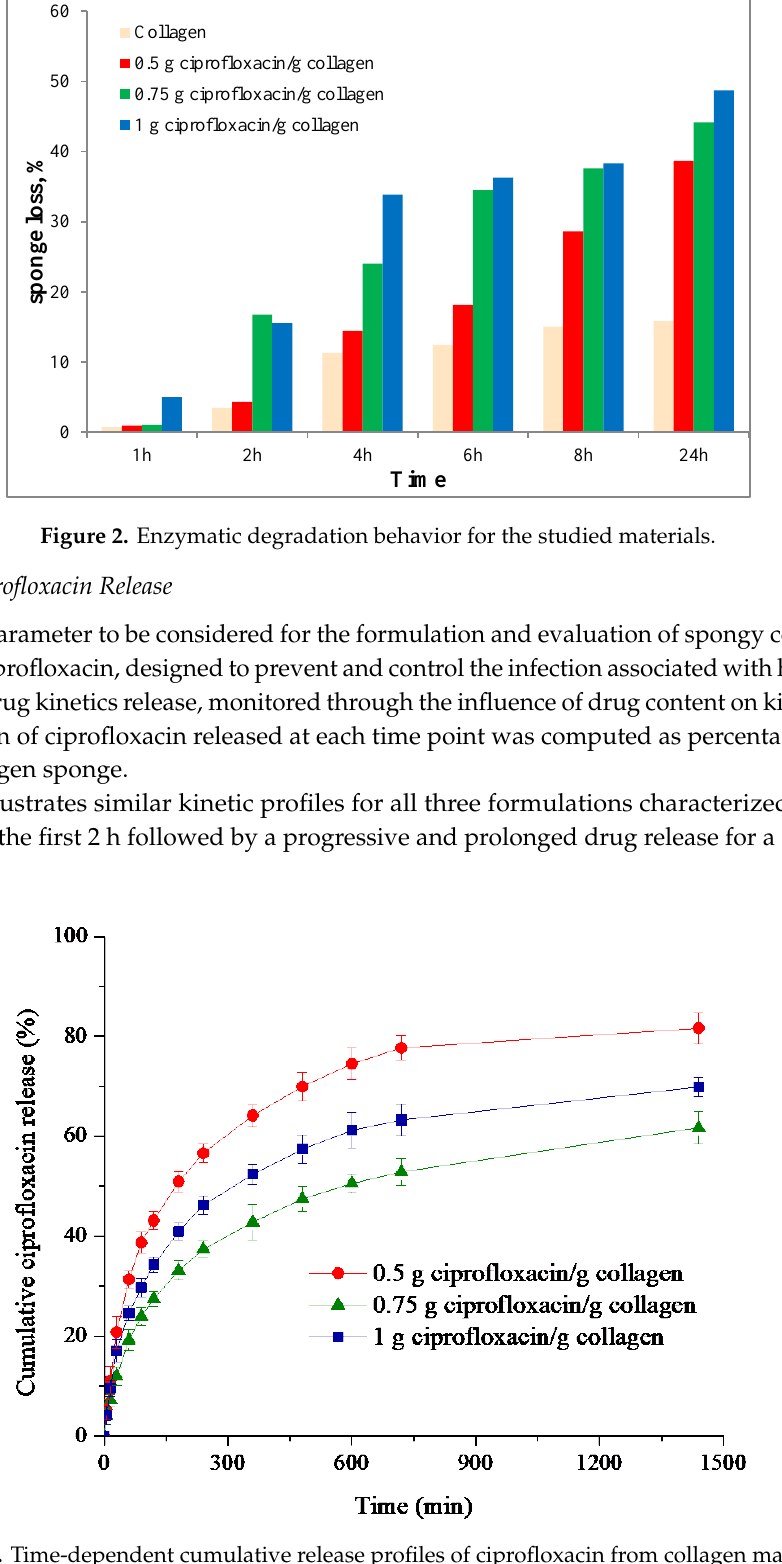
Figure 3. Time-dependent cumulative release profiles of ciprofloxacin from collagen matrices.